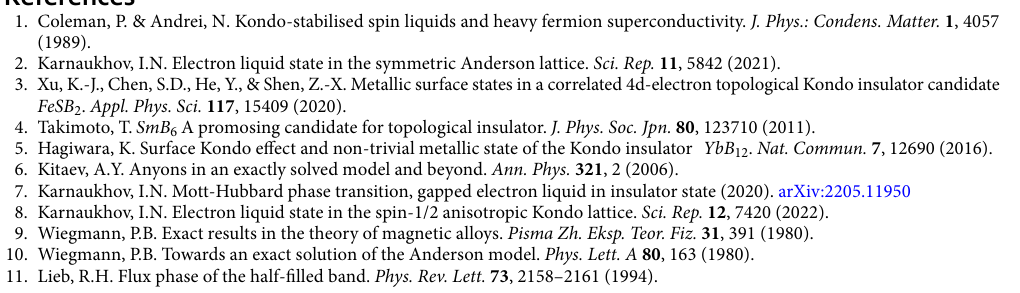
Figure 4. (Color online) A low energy part of the spectrum of the symmetric Anderson square lattice as a function of the wave vector calculated under the condition v < 2 √ 2 (cid:31) for v 0.0828 ( b 0 at H c ( a ), (cid:31) = =